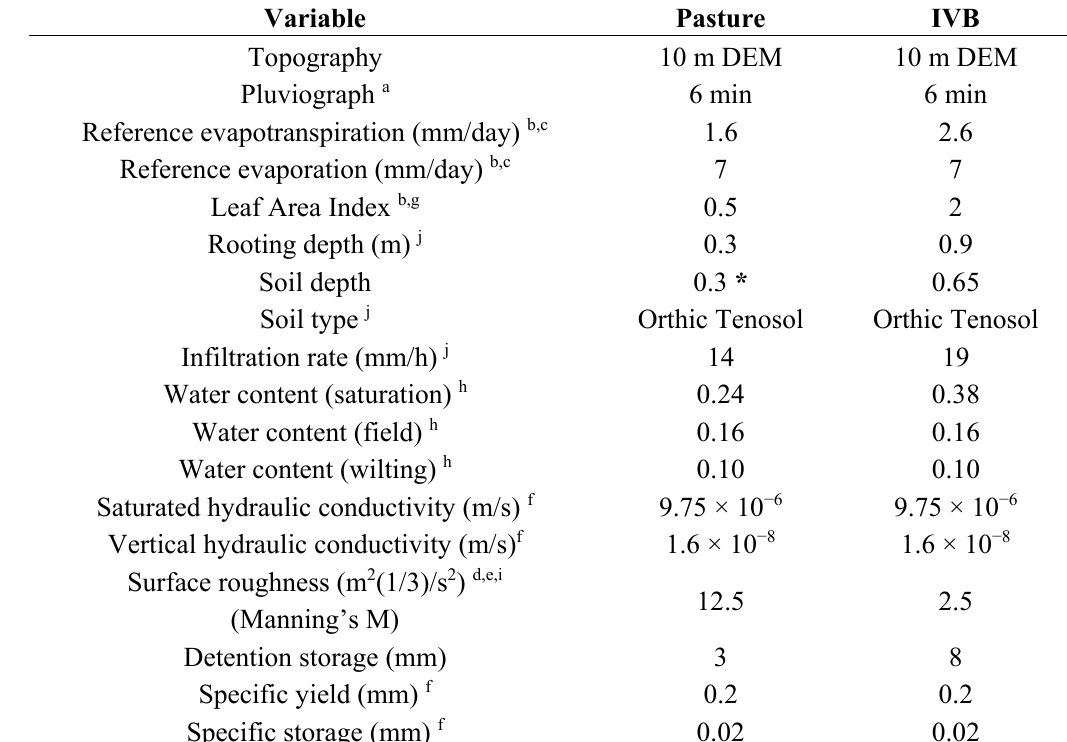
Table 1. Simulation variables and parameter estimates for two land